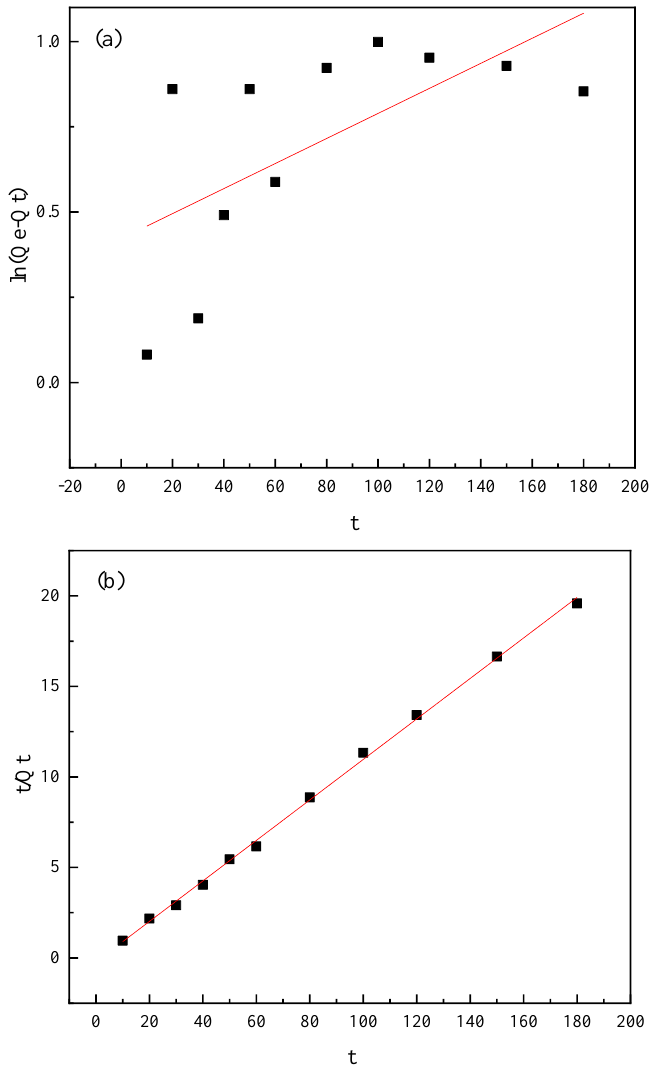
Figure 7. Kinetic fitting of thiourea adsorption on pyrite: ( a ) Pseudo-first-order kinetic plot and ( b ) pseudo-second-order kinetic plot. Table 2. Kinetic fitting results of thiourea adsorption on mica and pyrite.